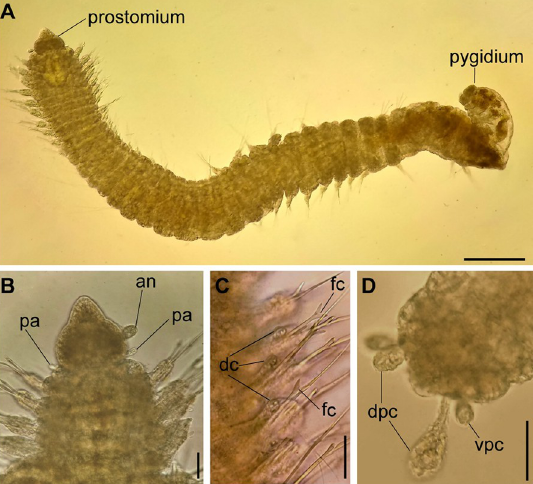
Fig 2. Meiodorvillea minuta (Hartman, 1965), ZUEC-POL. (A) complete specimen, dorsal view; (B) anterior region, dorsal view; (C) parapodia from anterior region, dorsal view; (D) pygidium, ventral view. Abbreviations: an = antenna; dc = dorsal cirrus; dpc = dorsal pygidial cirrus; fc = furcate chaeta; pa = palp; vpc = ventral pygidial cirrus. Scales: (A) = 200 μ m; (B,C) = 62.5 μ m; (D) = 31.25 μ m.